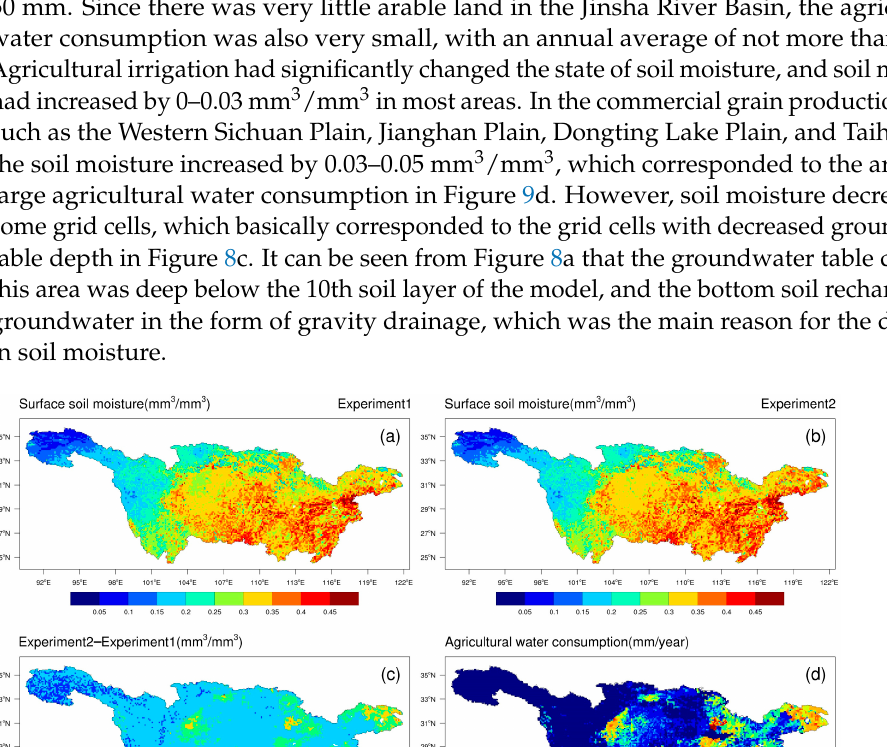
Table 5. The contribution rate of various factors to the variation in the discharge of 15 hydrological stations in the Yangtze River Basin.